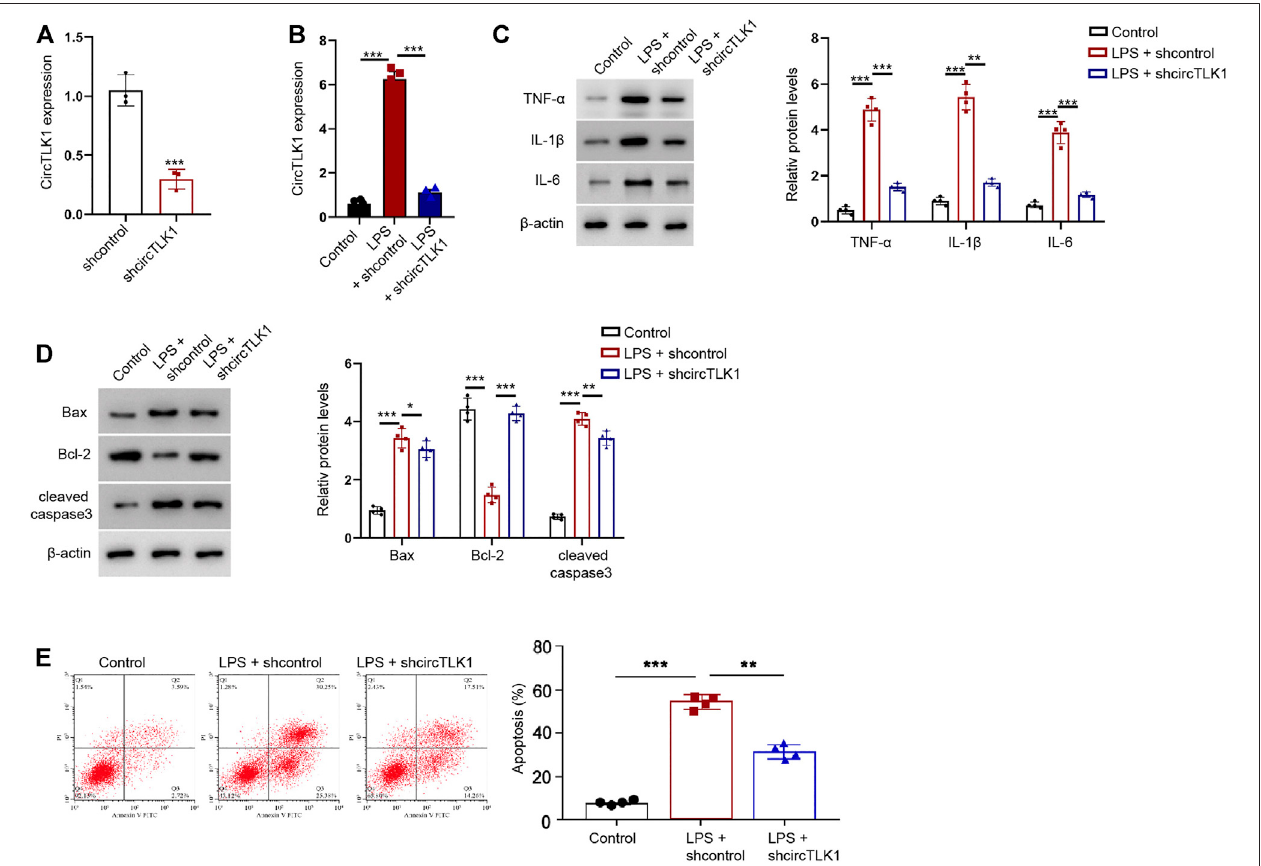
FIGURE 3 | CircTLK1 knockdown relieves LPS-induced in fl ammation and apoptosis in the HK-2 cells. (A) Expression of circTLK1 was detected by qPCR in HK-2 cells treated with circTLK1 shRNA. (B – E) For the induction of the cell injury model, the HK-2 cells were treated with LPS (1 mg/L) for 24 h after the cell concentration reached80%,followedbythetreatmentofcircTLK1 shRNA. (B) qPCRanalysisofcircTLK1 expression. (C) WesternblotanalysisofTNF- α ,IL-1 β ,andIL-6. (D) Western blot analysis of Bax, Bcl-2, and cleaved caspase-3. (E) Flow cytometry analysis of apoptosis. The experiments were replicated at least three times, mean ± SD, * P < 0.05, ** P < 0.01, *** P <